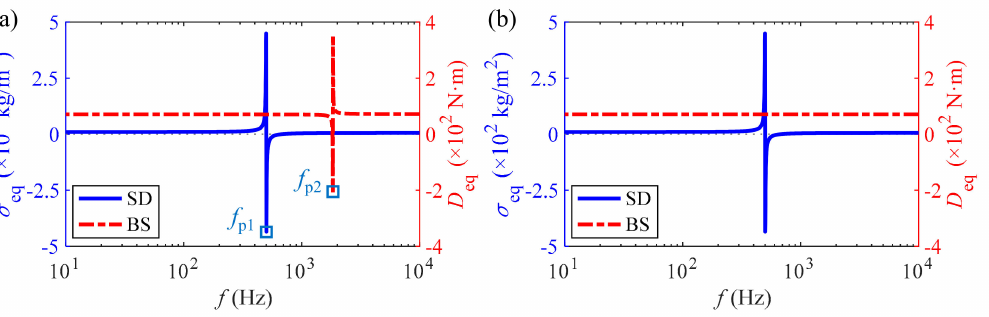
Figure 5. Effect of the RL shunt circuit with R = 100 Ω on dual equivalent properties of the metamate- rial: ( a ) L = 4 H and ( b ) L = 0